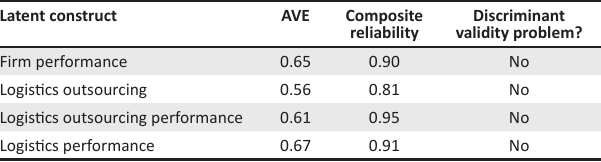
TABLE 3: Measurement model evaluation.